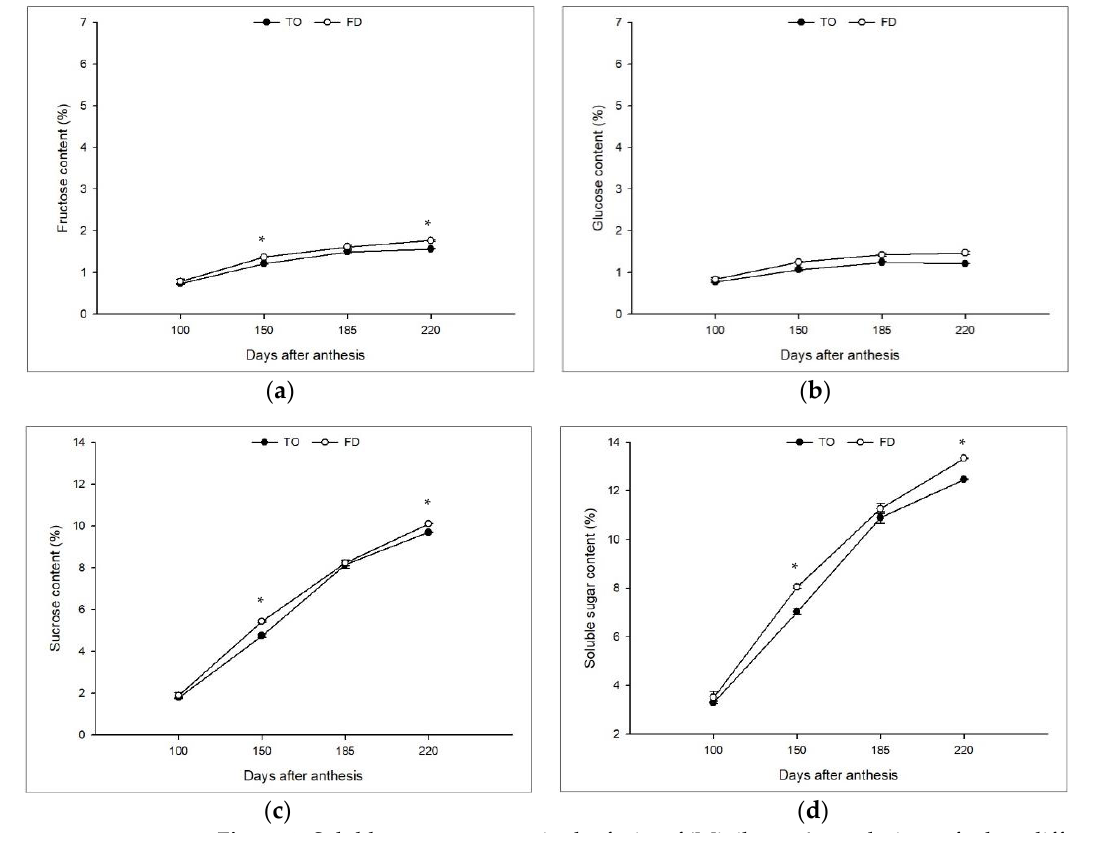
Figure 3. Soluble sugar contents in the fruits of ‘Minihyang’ mandarin grafted on different rootstocks. ( a ) fructose; ( b ) glucose; ( c ) sucrose; ( d ) total soluble sugars. * Mean separation within columns by T-test at 5% level.